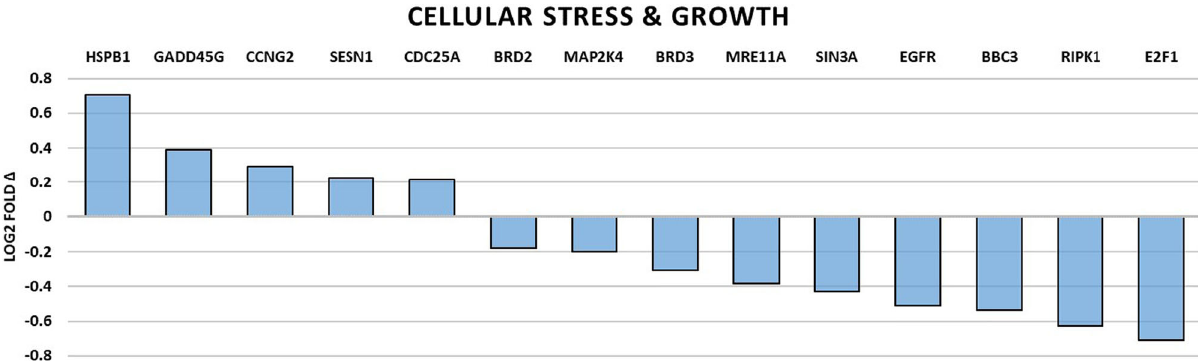
Fig. 4 Space fl ight-induced changes of gene expression related to cellular stress and growth function. Bar graph summarizing log2 fold- changes of signi fi cantly differentially expressed genes (DEG) ( p < 0.05) in the fl ight (FLT) group relative to the ground control (GC) group in genes directly related to cellular stress and growth function. N = 6/group. p values are calculated using one-way analysis of variance (ANOVA) and Tukey ’ s HSD (honestly signi fi cant difference) test. Source data are provided as a Source Data fi le.